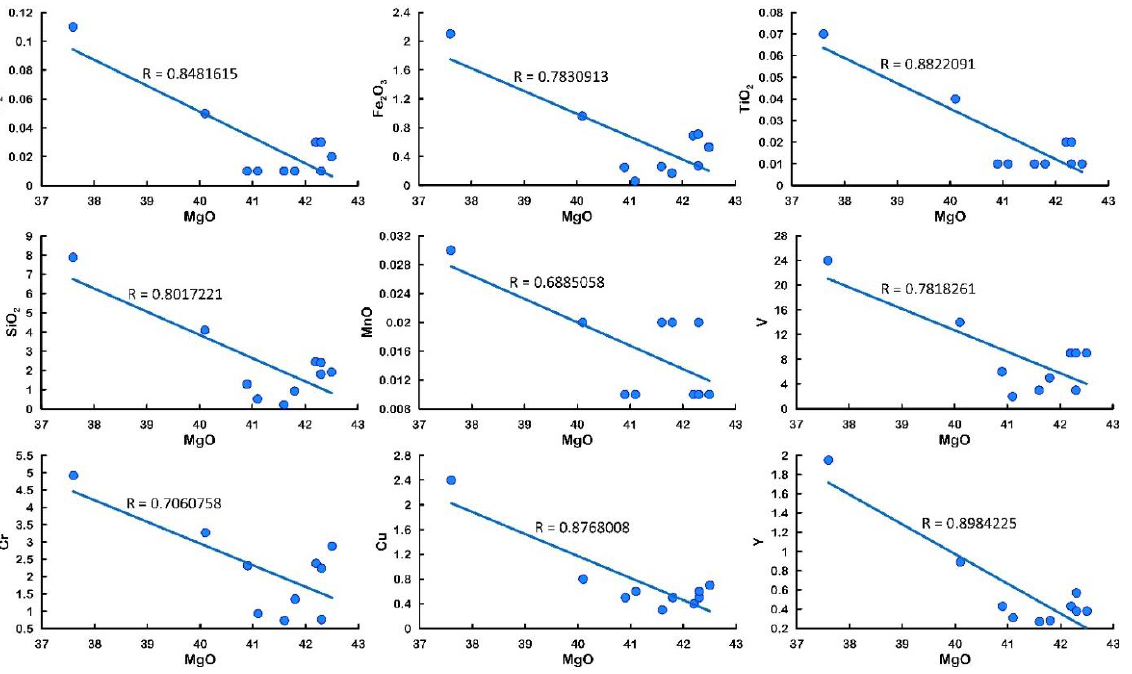
Figure 6. Negative correlations between MgO and some selected major oxides and trace elements of stromatolites. Table 2. Major oxide contents of the stromatolites from Lake Salda, in weight percent (wt.%).